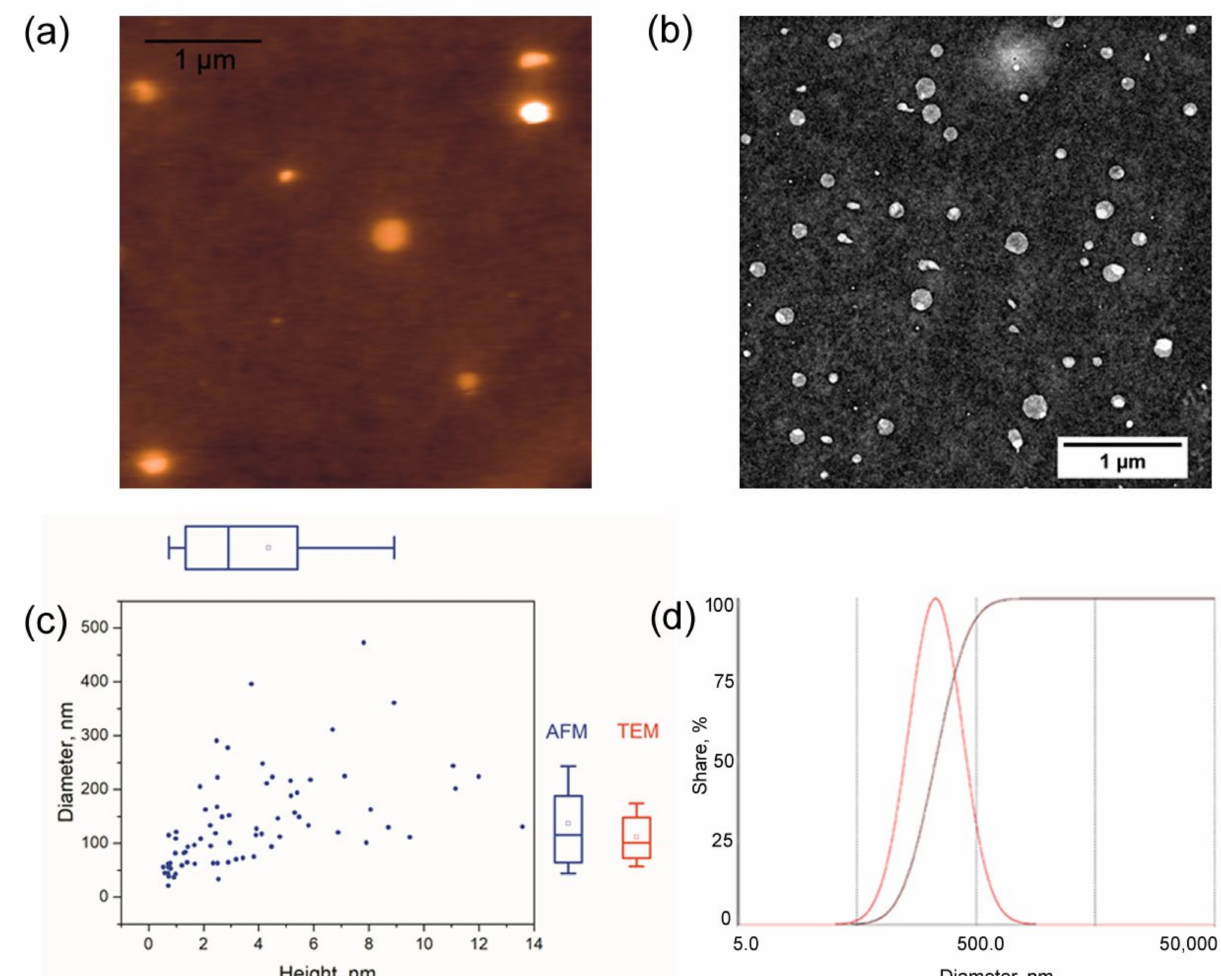
Figure 2. Characterization of DR5- B -conjugated Amph-PVP nanoparticles: ( a ) AFM image (Z range 15 nm); ( b ) TEM image; ( c ) diagram of the heights and widths of individual nanoparticles (blue, AFM data) and the diameters measured using TEM (in red); ( d ) hydrodynamic size distribution according to DLS. The box-and-whisker plots show the 10, 25, 50, 75 and 90 percentiles; the square mark shows the